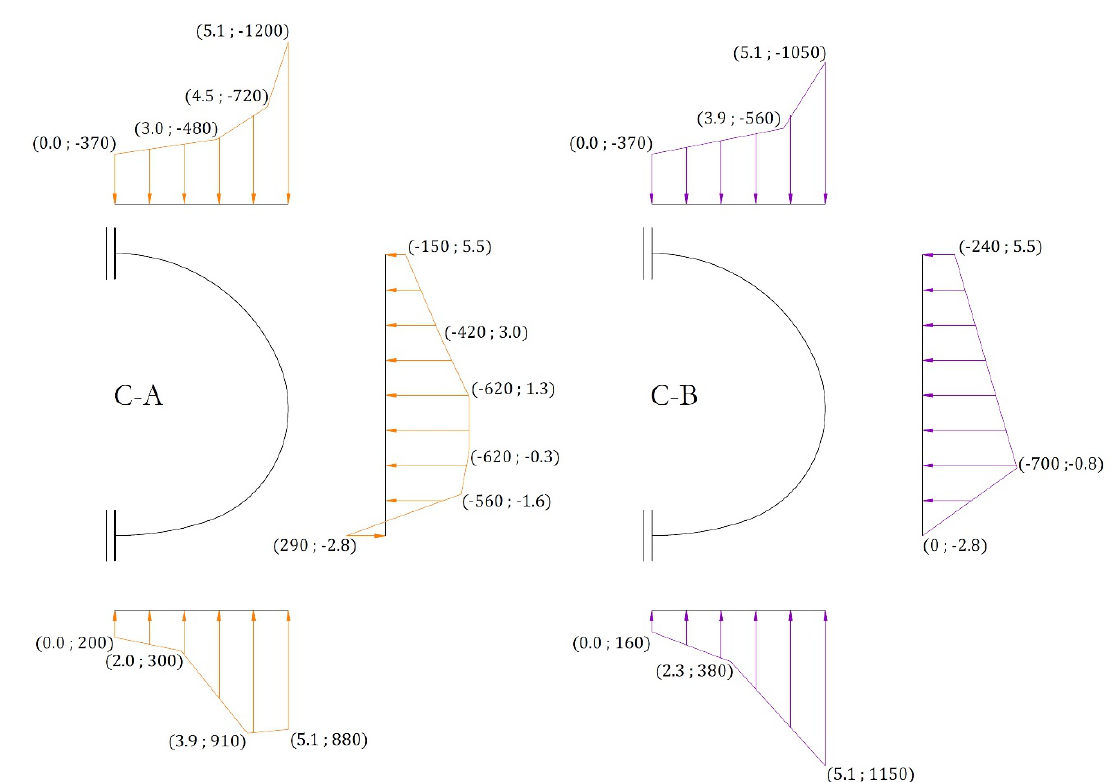
Figure 1. Loads calibrated from “ideal” compatibilization load proposed for comparison of compatibility with varying loading complexity.